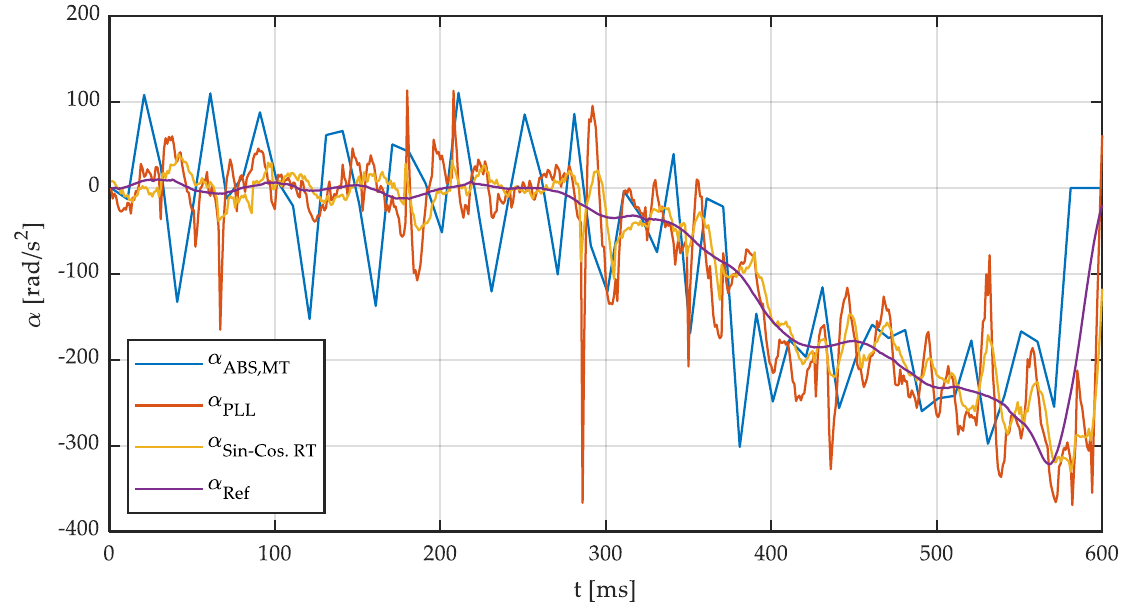
Figure 16. Wheel angular speed and linear speed vs. time. Vehicle speed 60 km/h.